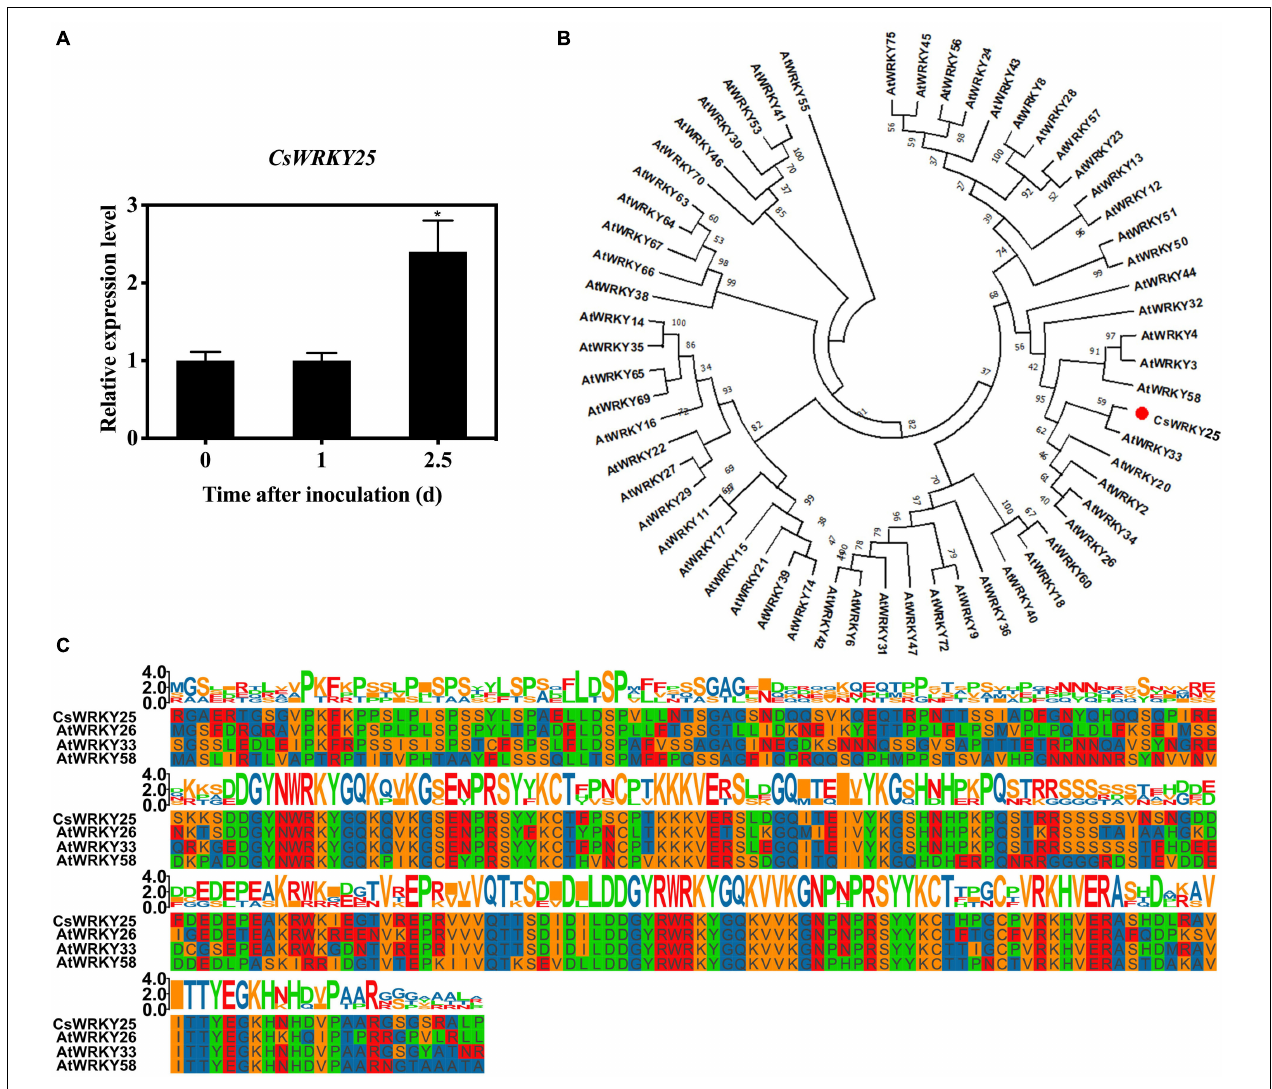
FIGURE 1 | Sequence and phylogenetic analyses of CsWRKY25. (A) The relative expression levels of CsWRKY25 in P. digitatum infected citrus peel. Values equal the mean ± SE ( n = 3). (B) The phylogenetic tree of CsWRKY25 and WRKYs from Arabidopsis thaliana . (C) Multiple alignment of CsWRKY25 with Arabidopsis thaliana AtWRKY26, AtWRKY33 and AtWRKY58. P values were regarded as statistically significant at * P < 0.05.